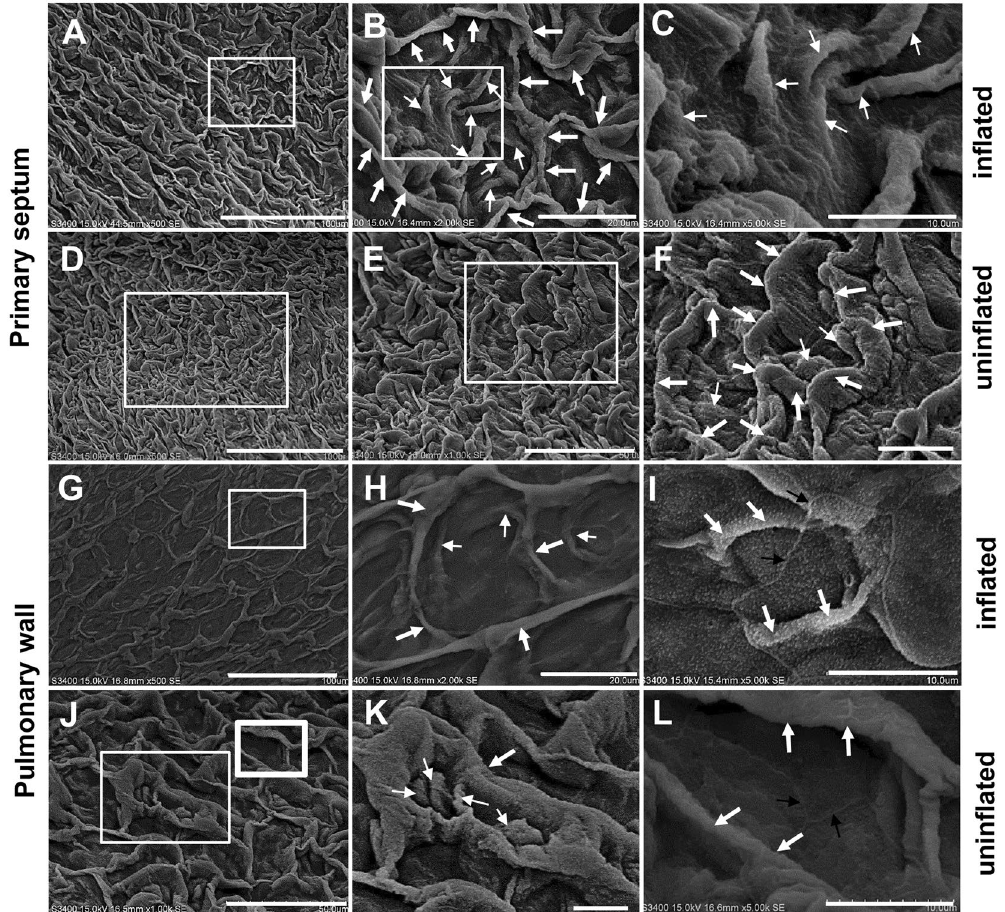
Figure 4. Ultrastructure of septum and pulmonary wall in B. gargarizans by SEM. SEM observation of the septa and pulmonary wall in B. gargarizans . The lattices include thick folds ( A,B ), thin folds ( B,C ) and the bottom ( B ) in the primary septa of inflated lungs, and the thin folds are located in the bottom ( B ). The uninflated lattices ( D,E ) contain thick folds ( F ) and thin folds ( F ) in the septa of uninflated lungs. Lattices ( G,I ), thick folds ( H ), spare thin folds ( H ) and absence of thin folds in the exposed bottom ( I ) in the pulmonary wall of inflated lungs. In the pulmonary wall of uninflated lungs, the lattices ( J,L ), thick folds ( K,L ) and sparse thin folds ( K ) shrink, becoming thick or spherical ( K ). B, C, E, F, H, and K show enlarged images of the boxes in A, B, D, E, G, and J, respectively. L shows an enlarged image of the thick boxes in J. The white thick arrow shows a thick fold, the white thin arrow indicates a thin fold, and the black arrow shows the boundary of an epithelial cell. Scale bar, A, D, G: 100 μ m; B, H: 20 μ m; C, F, I, K, L: 10 μ m; E, J: 50 μ